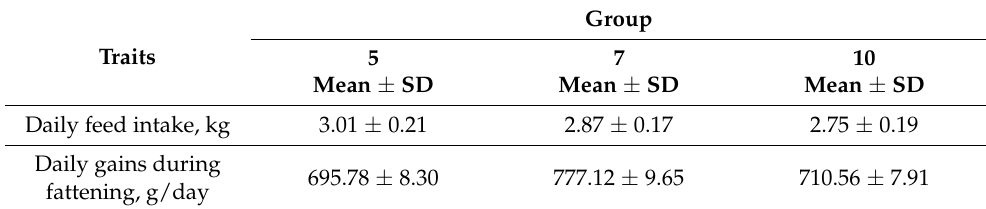
Table 2. Results of the preliminary